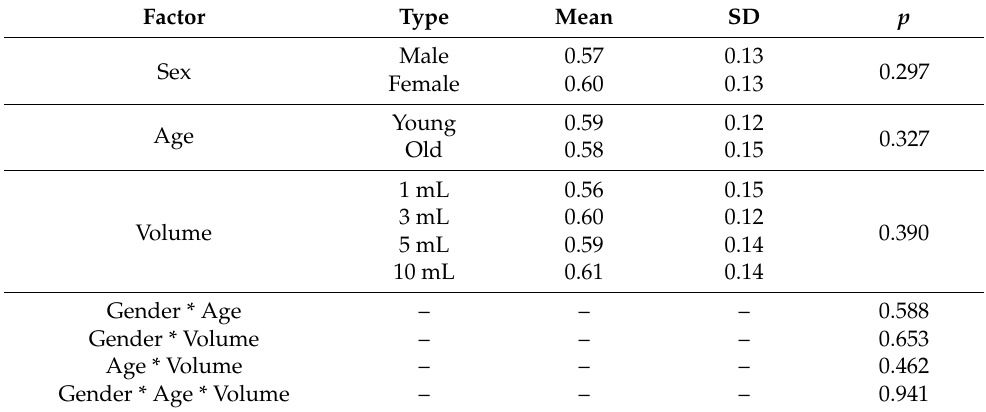
Figure 12. Comparison of the first phase duration ( T TC1 ) in the thyroid cartilage excursion by ( a ) sex and ( b ) age. Table 8. Analysis of variance results of first phase duration ( T TC1 ) in the thyroid cartilage